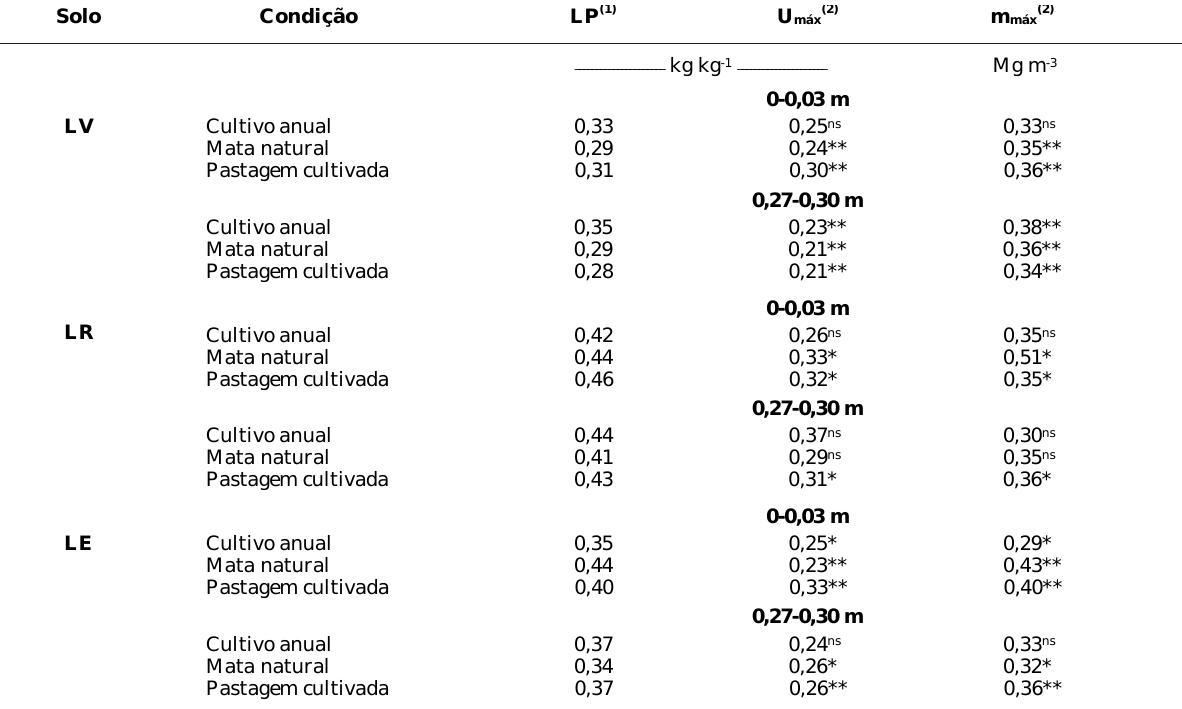
Quadro 2. Limites de plasticidade (LP), umidades máximas (U estimados pelas equações desenvolvidas neste estudo (m (LV), Latossolo Roxo (LR) e Latossolo Vermelho-Escuro (LE), nas profundidades de 0-0,03 e 0,27-0,30